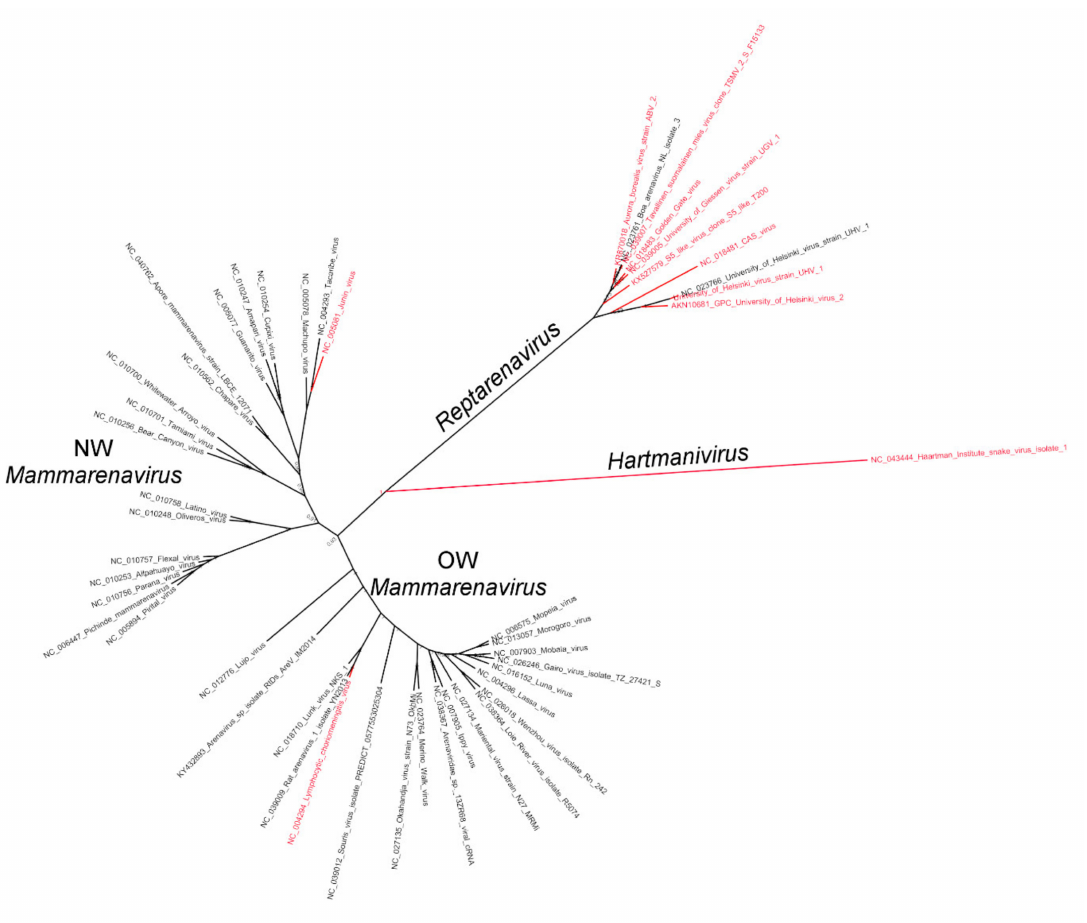
Figure 1. A phylogenetic tree based on the amino acid sequences of arenavirus GPCs. The GPCs included in the study are in red